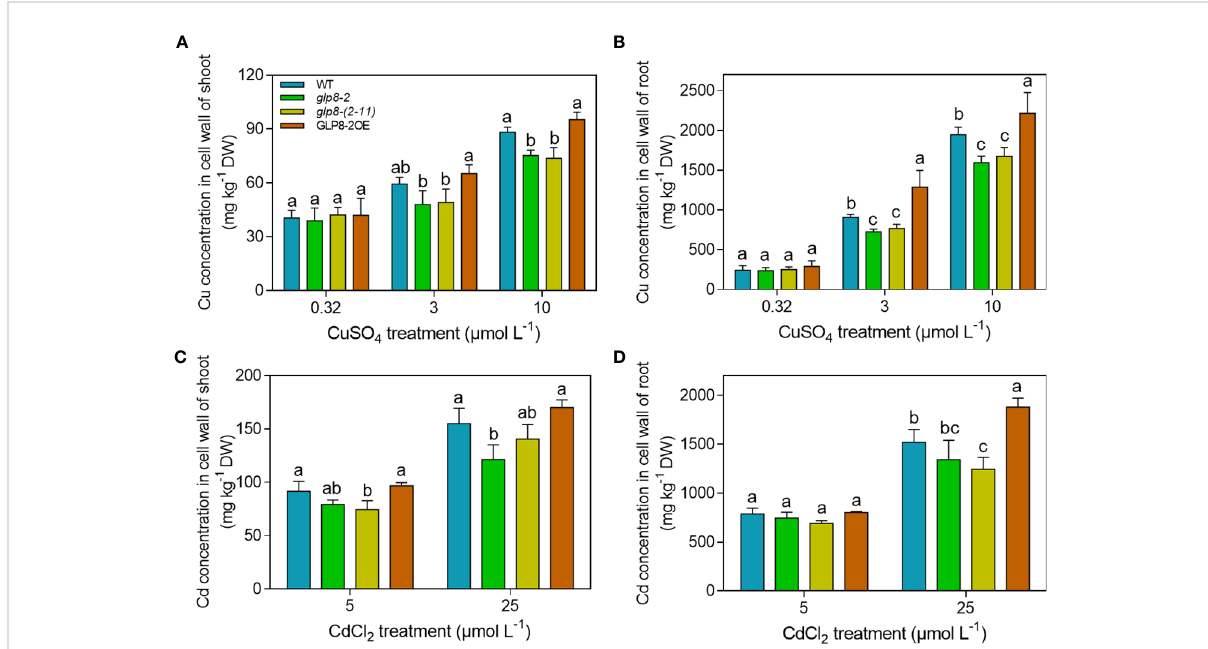
FIGURE 4 Knockout of OsGLPs affects heavy metal accumulation in the cell walls of rice. (A, B) Cu concentrations in the cell walls of roots and shoots of two-week-old seedlings treated with 3 or 10 m mol L − 1 CuSO 4 for 5 days. (C, D) Cd concentrations in the cell walls of roots and shoots of two- week-old seedlings treated with 5 or 25 m mol L − 1 CdCl 2 for 5 days. Values are the mean ± SD; n = 3. Different letters indicate a difference of p ≤ 0.05 by the LSD